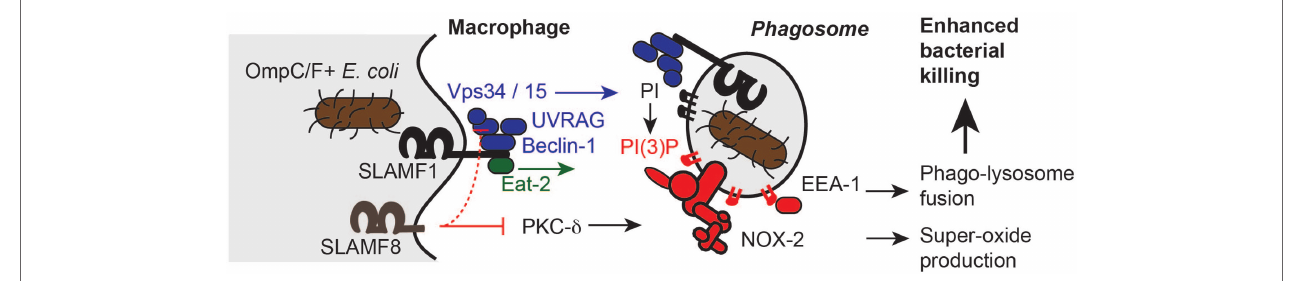
FiGURe 4 | Slamf1 affects phagosome functions in two ways, after binding to E. coli . OmpC/F + E. coli can be bound by SLAMF1. Subsequently, SLAMF1 is internalized into the progressing phagosome. The Vps34/15 > UVRAG > Beclin-1 complex is formed. PI is converted to PI3P, which is the docking lipid for subunits of the Nox2 complex as well as the tethering molecule EEA-1. The result of the docking of these proteins is the progression of phagosomes toward bactericidal phagolysosomes that are able to kill the internalized bacteria. The positive modulation of Nox2 complex formation by PKC-delta is inhibited by SLAMF8. There is preliminary evidence for an inhibition by SLAMF8 of Vps34/15 > UVRAG > Beclin-1 complex recruitment to